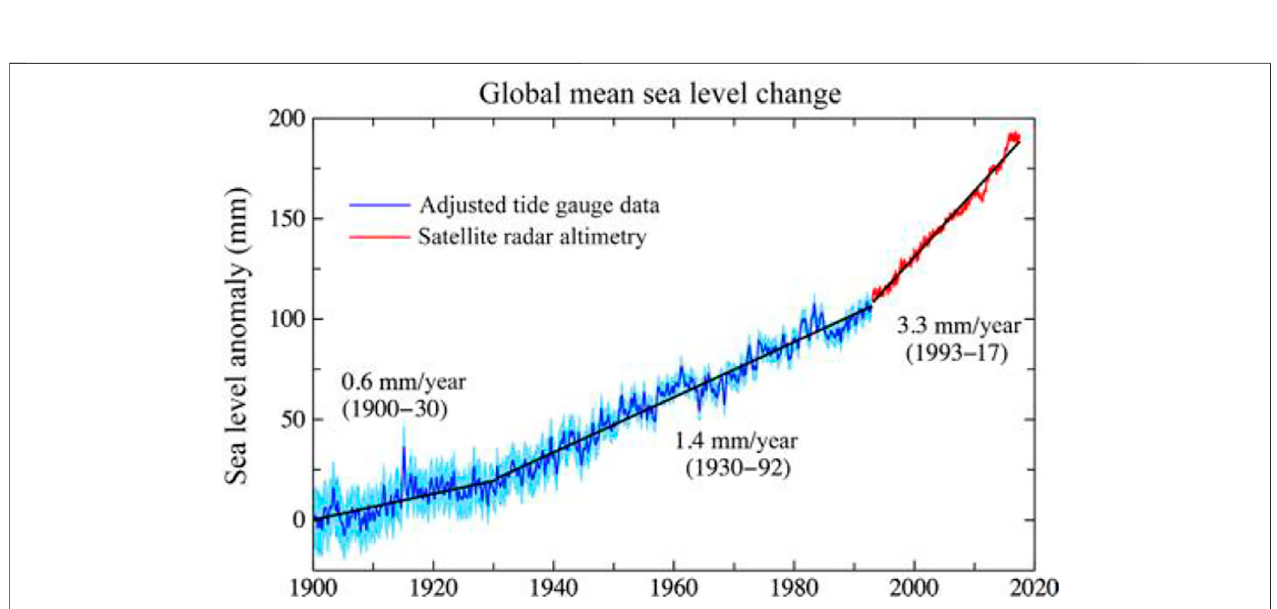
FIGURE 7 | Rates of global sea-level rise from 1900 to 2015 (Hansen et al., 2015. Reprinted by permission).